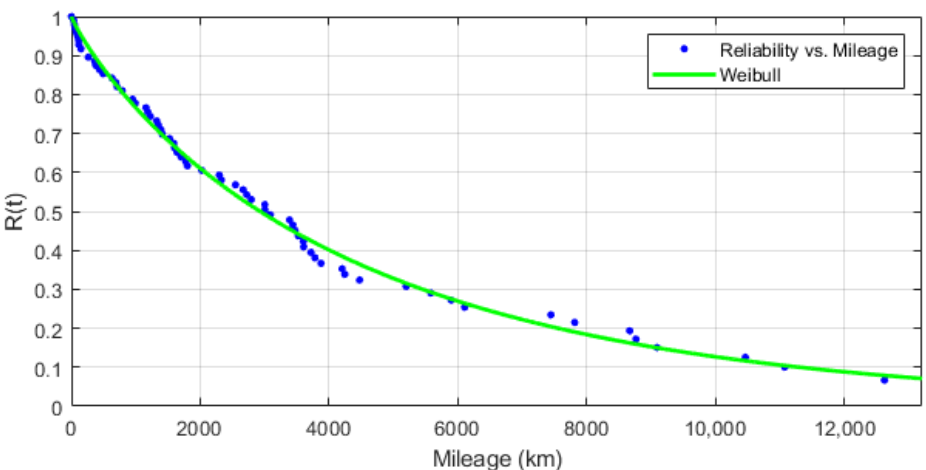
Figure 6. Graph presenting Weibull model fitting to estimated values of reliability function.